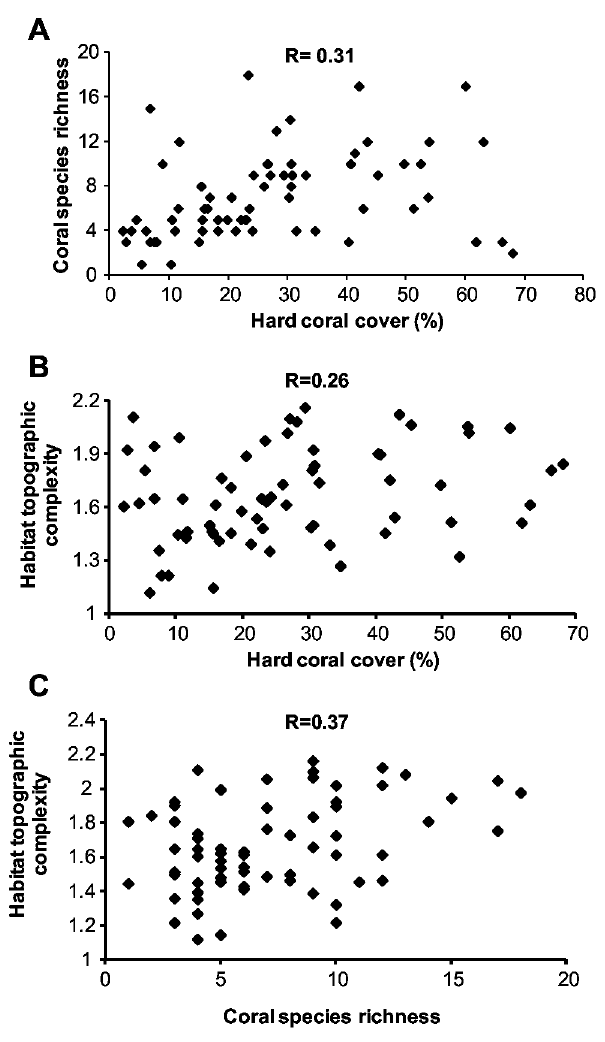
Figure 3. Relationships between habitat variables in the lagoon of Lizard Island, GBR. All relationships were statistically significant